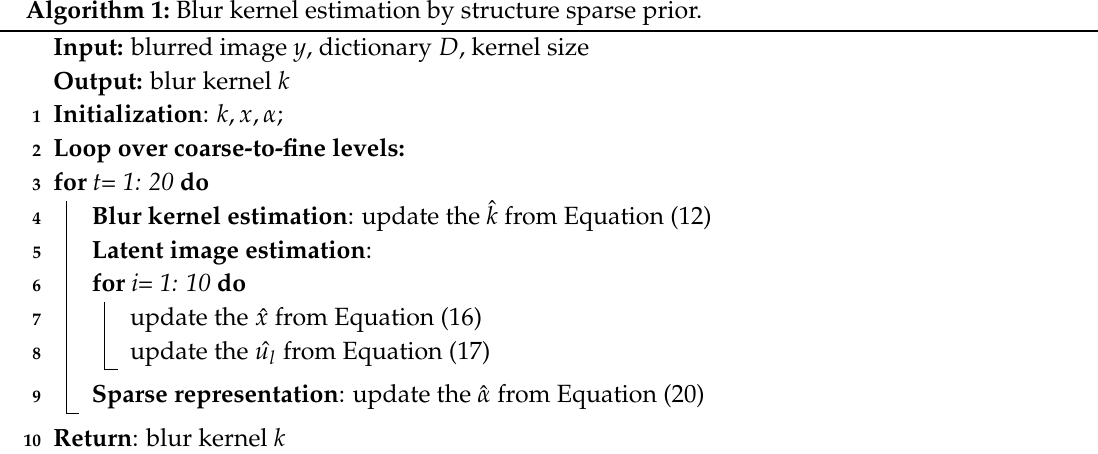
Algorithm 1: Blur kernel estimation by structure sparse